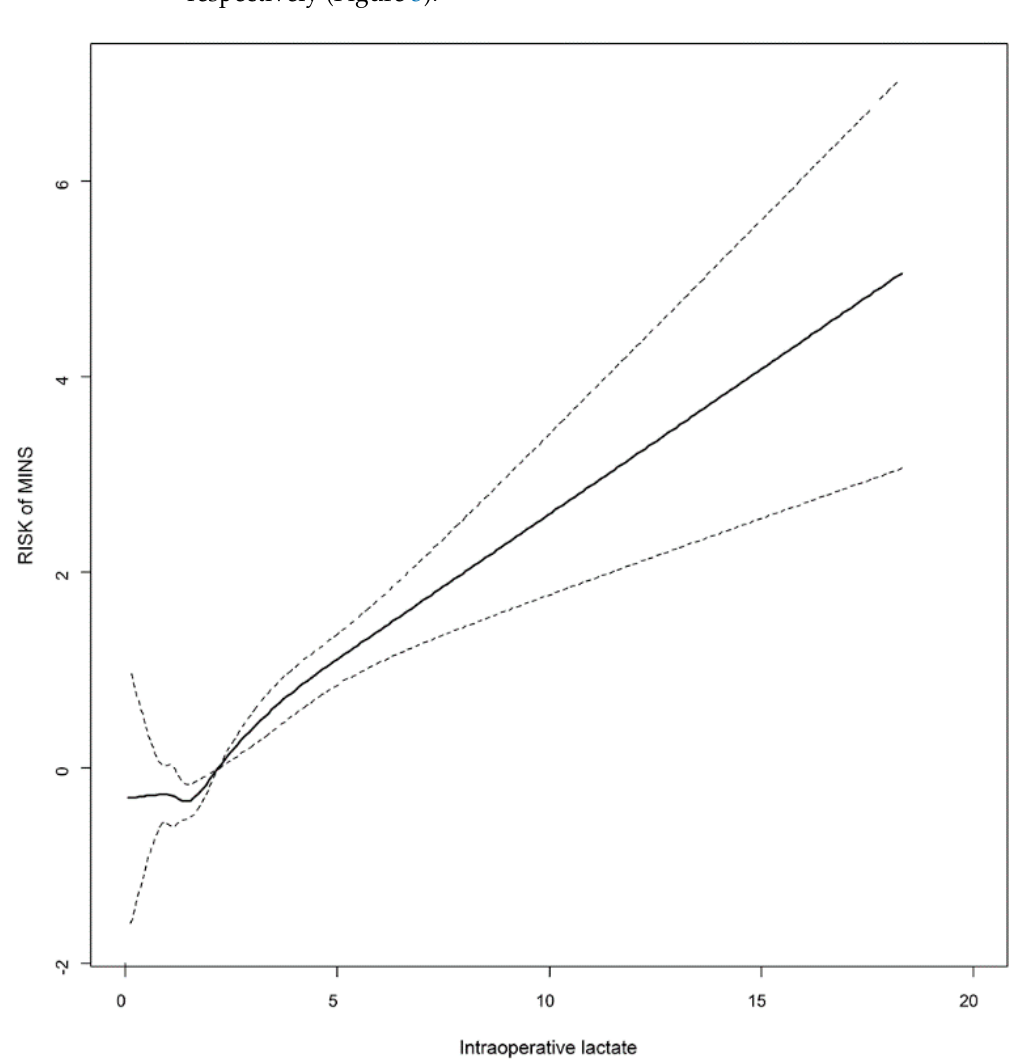
Figure 2. Estimated risk (95% confidence interval) of myocardial injury after noncardiac surgery according to lactate concentrations in the entire population. The dotted line represents confidence interval.